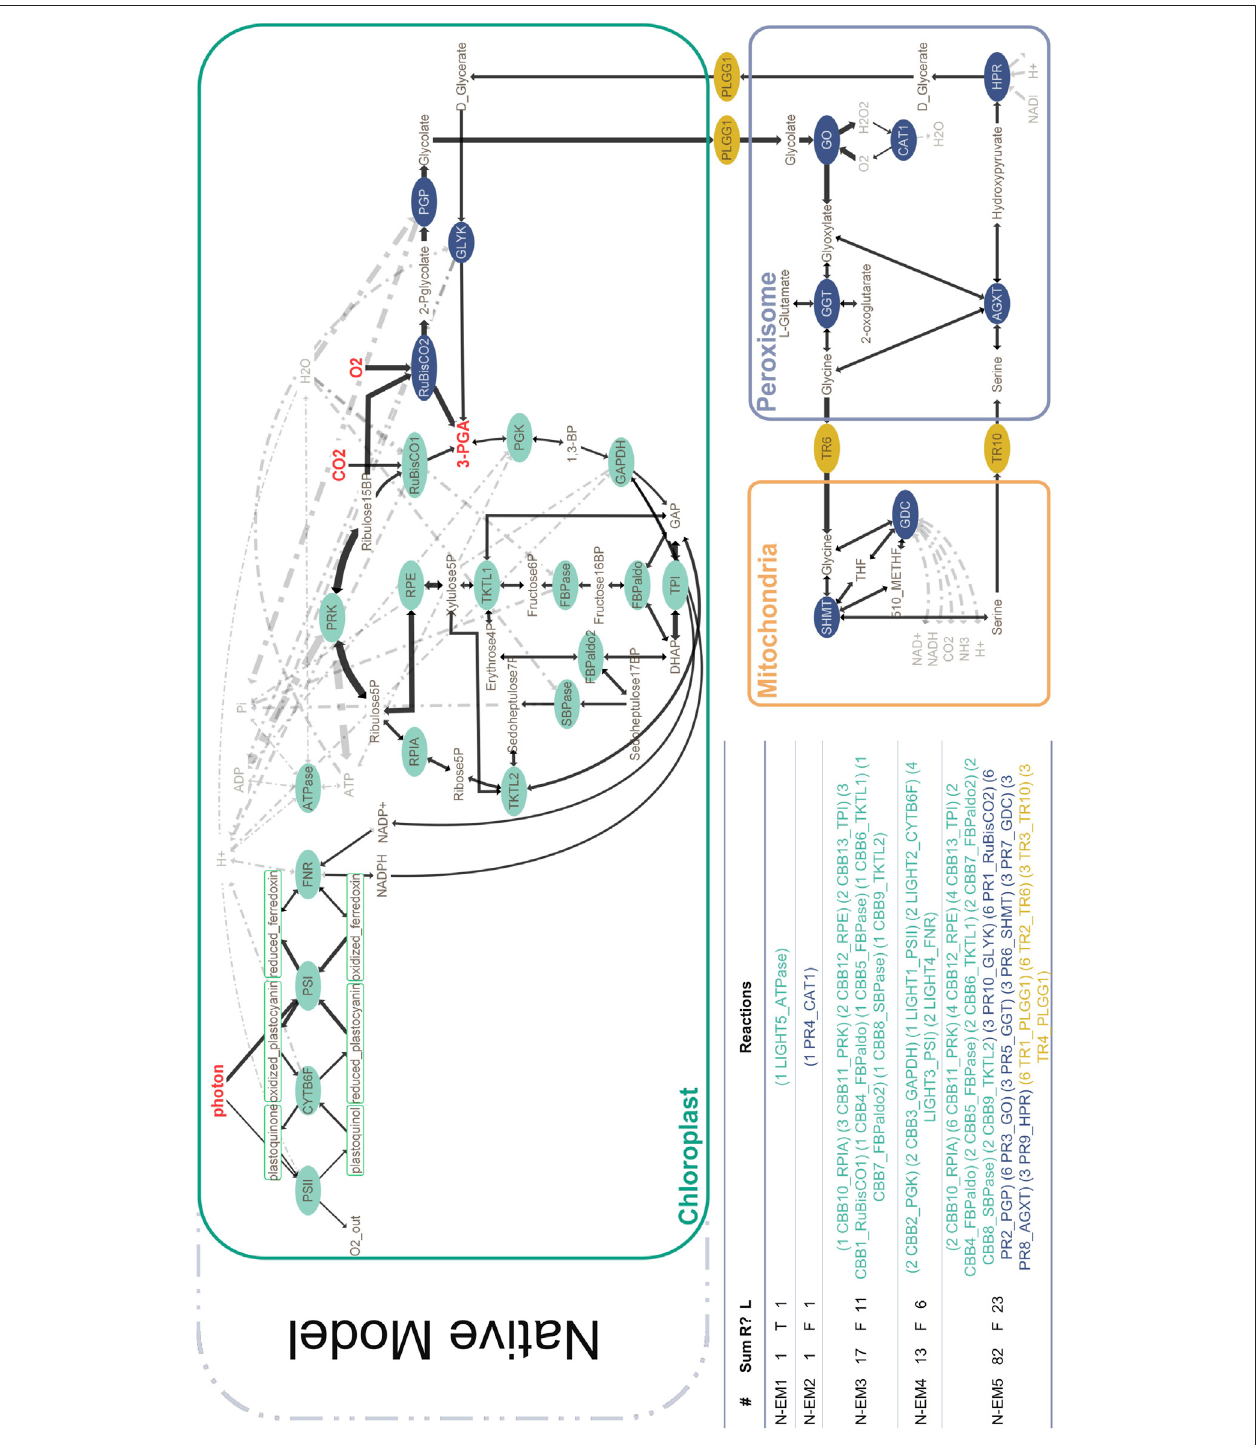
FIGURE 1 | Native model of photosynthesis (green) and photorespiration (blue) with transporters between organelles (gold). The elementary modes are calculated according to reversibility and metabolite classi fi cation (internal/external). Reversible reactions are shown with double-sided arrows. Sum: fl ux sum, R: reversibility, L: length.